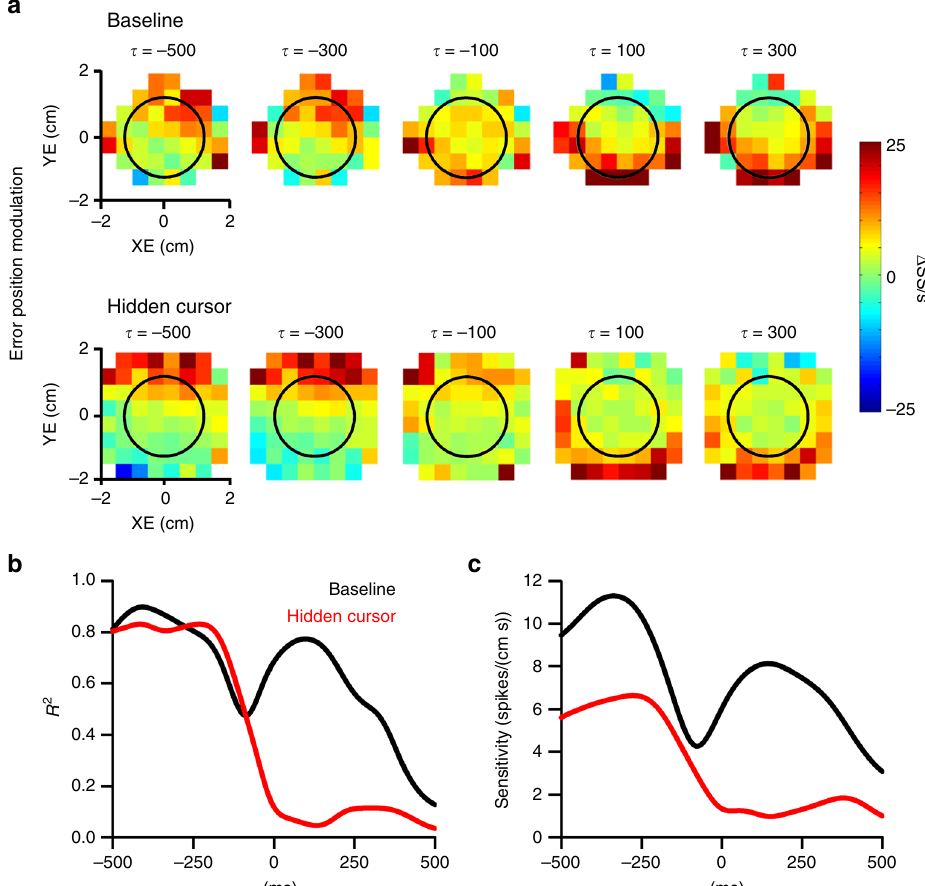
Fig. 6 Hidden cursor reduces feedback encoding of position error. a Firing maps for an example Purkinje cell with lead and lag SS encoding of position error in the baseline (top row) and hidden cursor (bottom row) conditions. Black circle indicates target edge. R 2 ( b ) and sensitivity ( c ) pro fi les for the Purkinje cell in a illustrate the decrease in lagged SS encoding of position